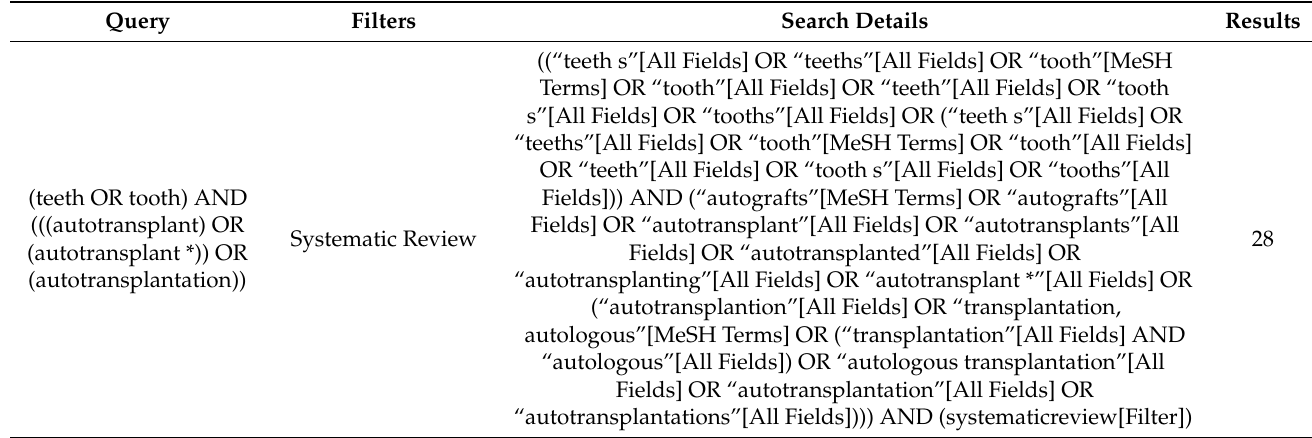
Table 1. Search Strategy for PubMed which was modified and used for other